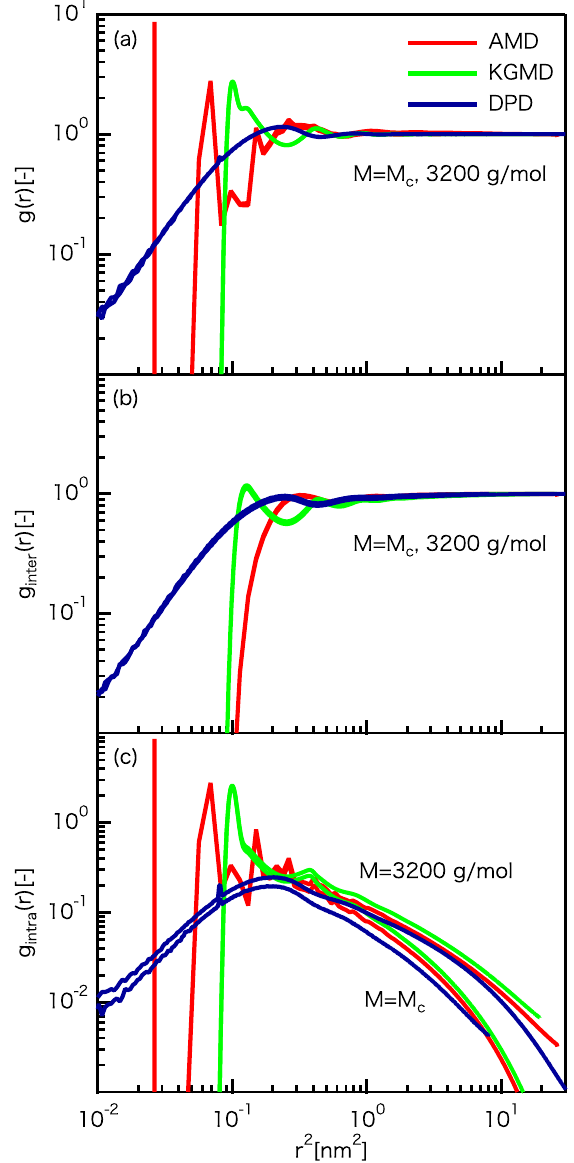
Figure 2. Comparison of the radial distribution function (RDFs) for the UA PE model and rescaled CG models. ( a ) RDF for all particles. ( b ) RDF for intermolecular particles. ( c ) RDF for intramolecular